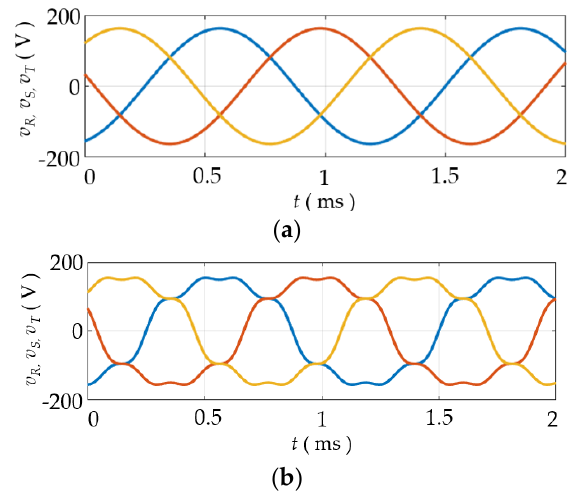
Figure 5. Input voltage waveforms for the simulated tests. ( a ) Phase voltage without distortion. ( b ) Distorted input voltage. ( c ) Unbalanced input voltage.